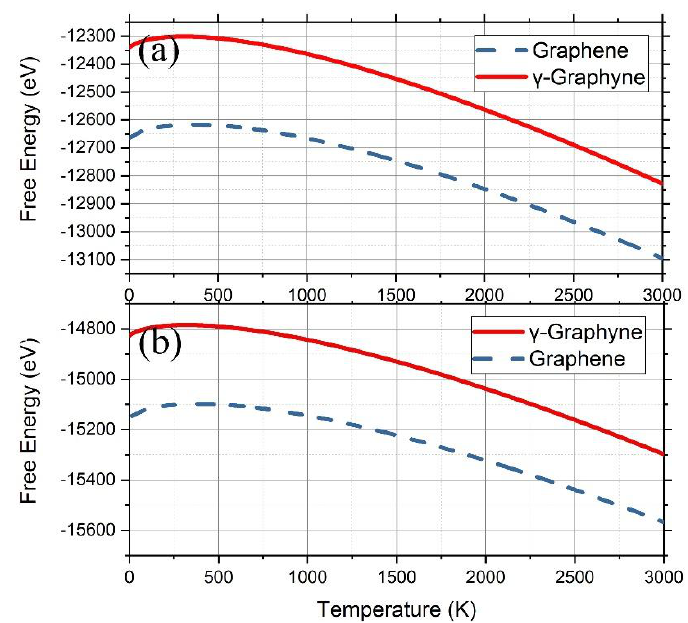
Figure 4. Free energy derived from the PF of graphene (blue dashed lines) and γ-graphyne (red solid lines) on the substrates of Cu [111] ( a ) and Ni [111] ( b